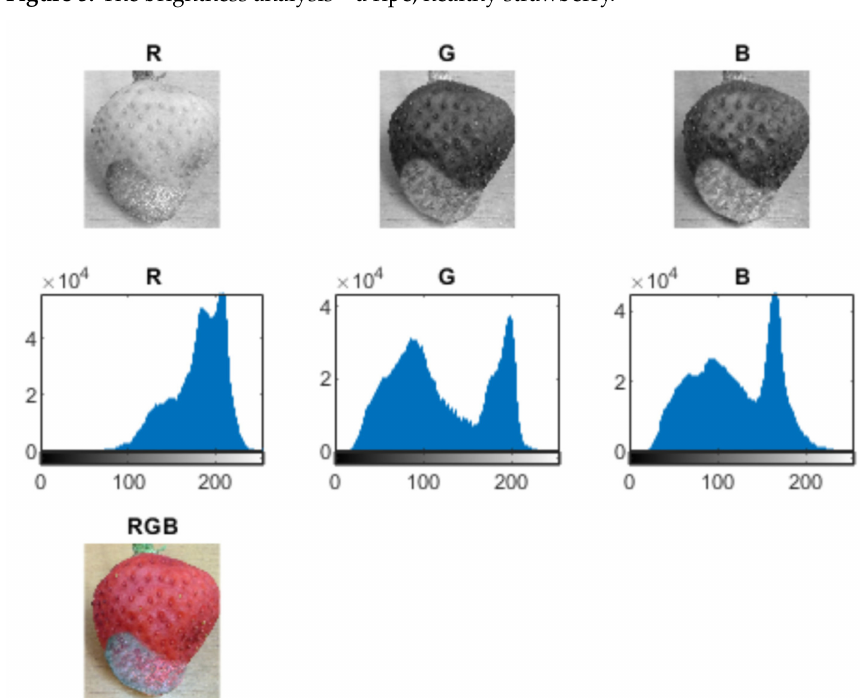
Figure 5. The brightness analysis—a ripe, healthy strawberry.